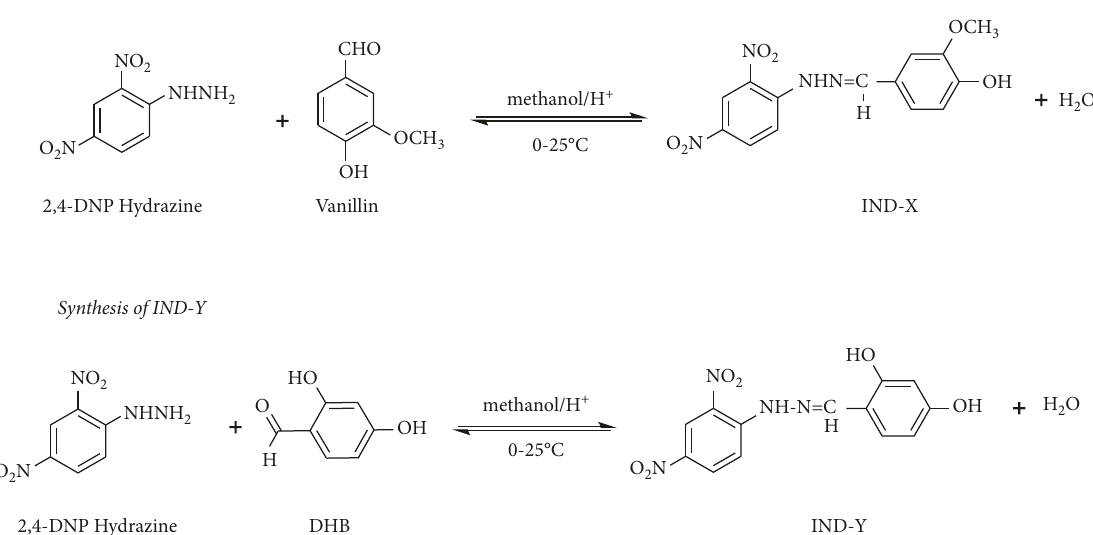
Figure 1: Synthetic schemes for the compounds 4-(2-(2,4-dinitrophenyl) hydrazone) methyl)-2 methoxy phenol (IND-X) and 4-(2-(2,4- dinitrophenyl) hydrazone) methyl) benzene-1,3-diol